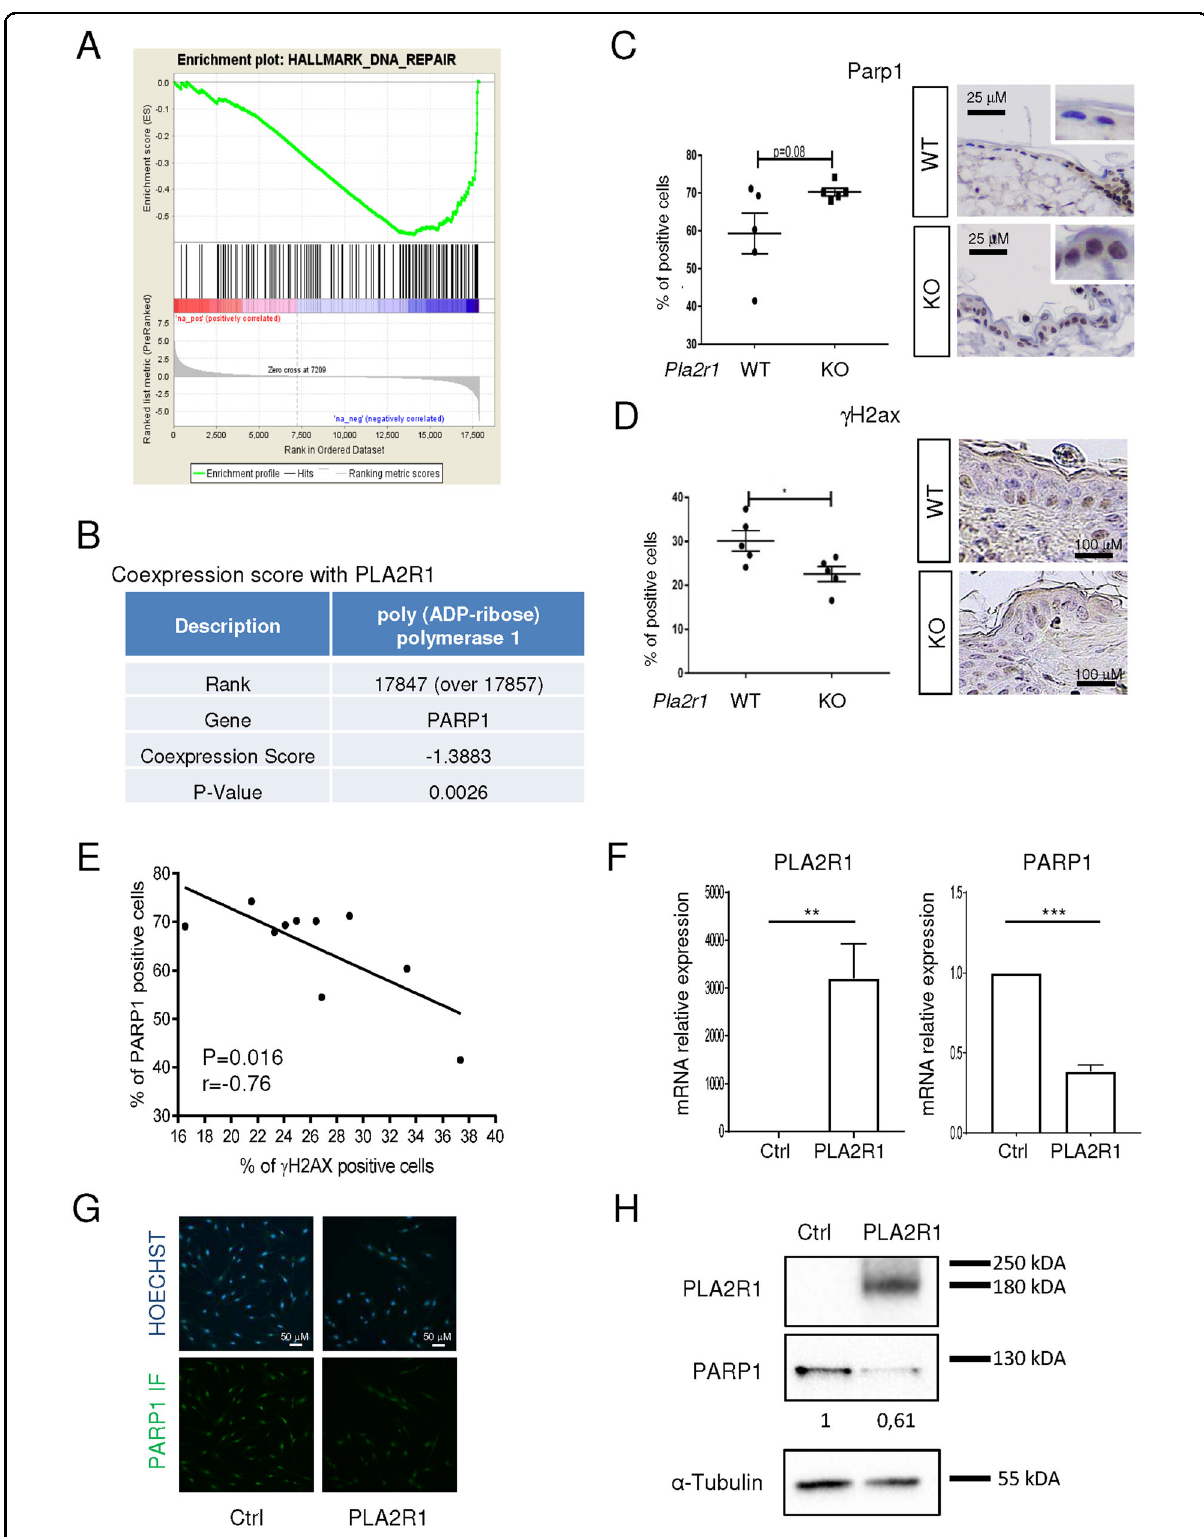
Fig. 2 (See legend on next